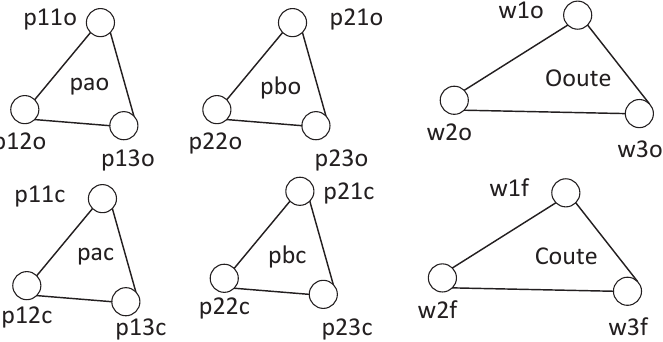
Figure 16. Correlations between executed sub-commands. A link denotes two correlations between two nodes.